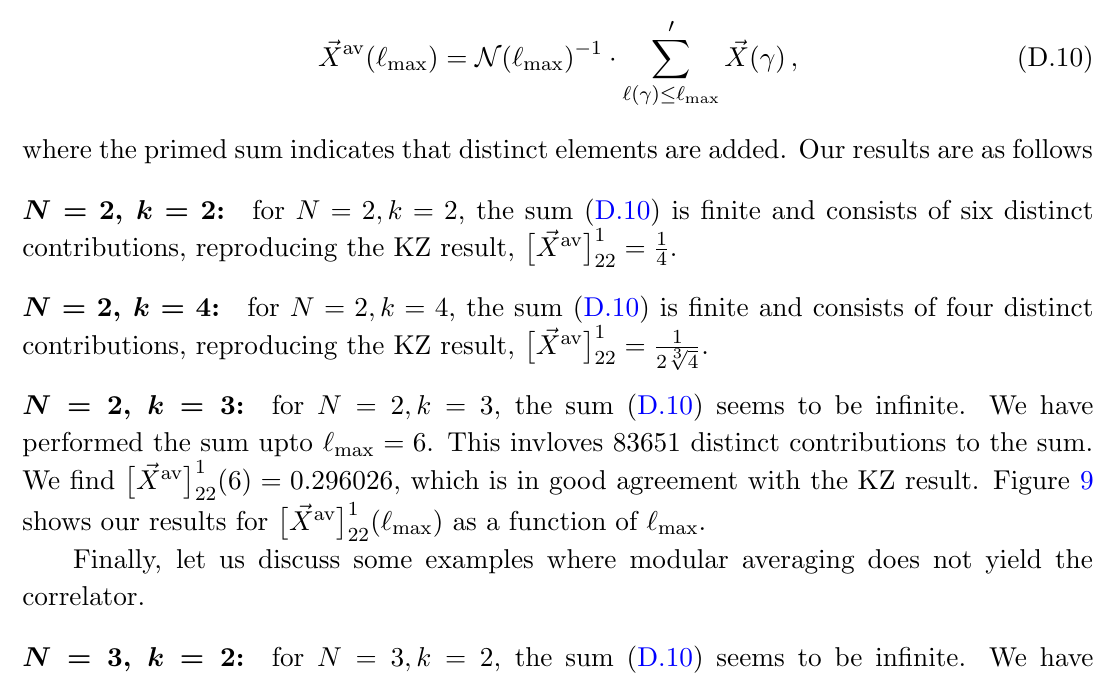
Figure 9 . Orange dots show horizontal line at 0 : 29831 represents the KZ